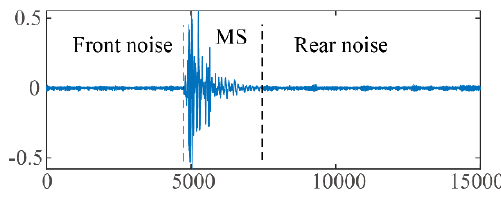
Figure 1. Three parts of a typical microseismic (MS) signal. Appl. Sci. 2020 , 10 , x FOR PEER REVIEW